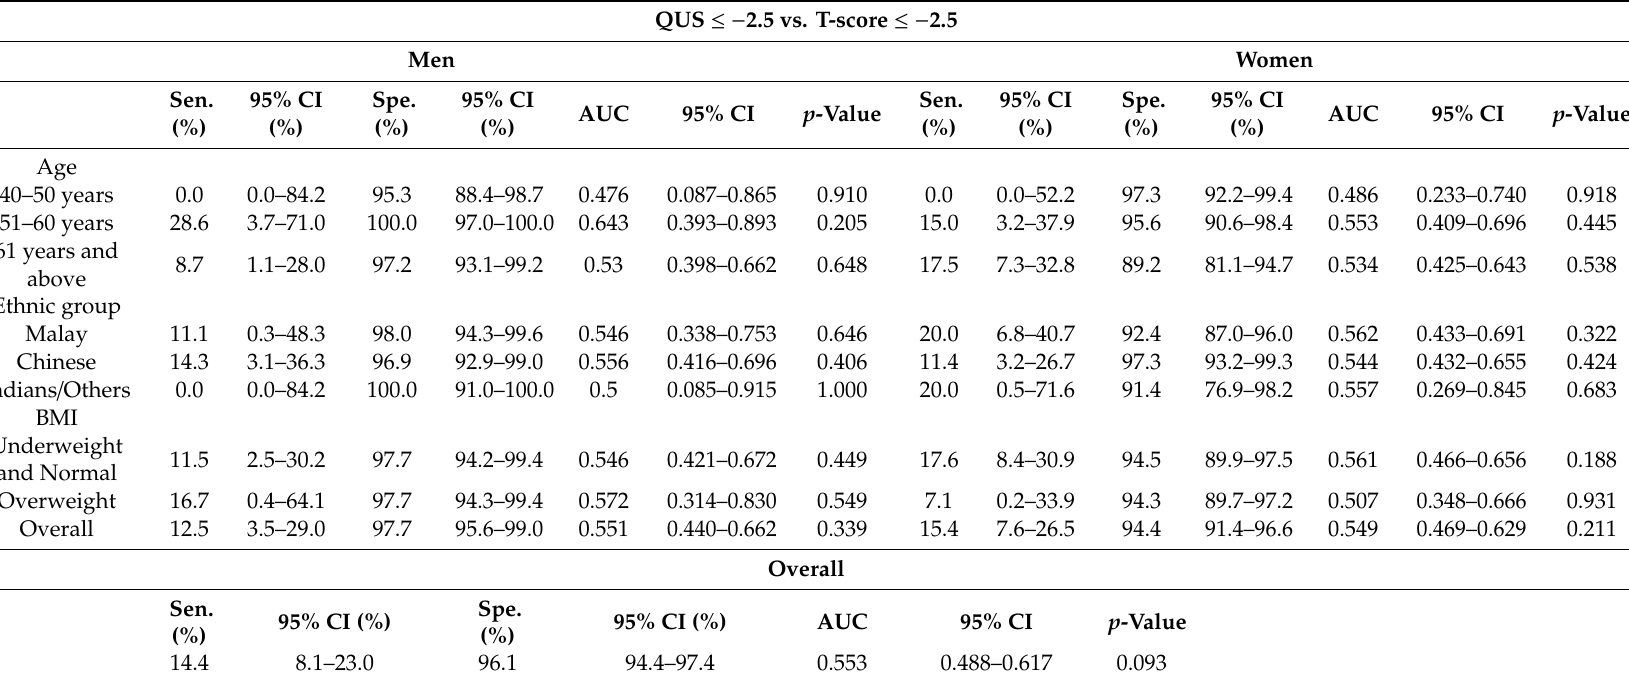
Table 4. The performance of CM-200 in identifying subjects with osteoporosis (DXA T-score ≤ −